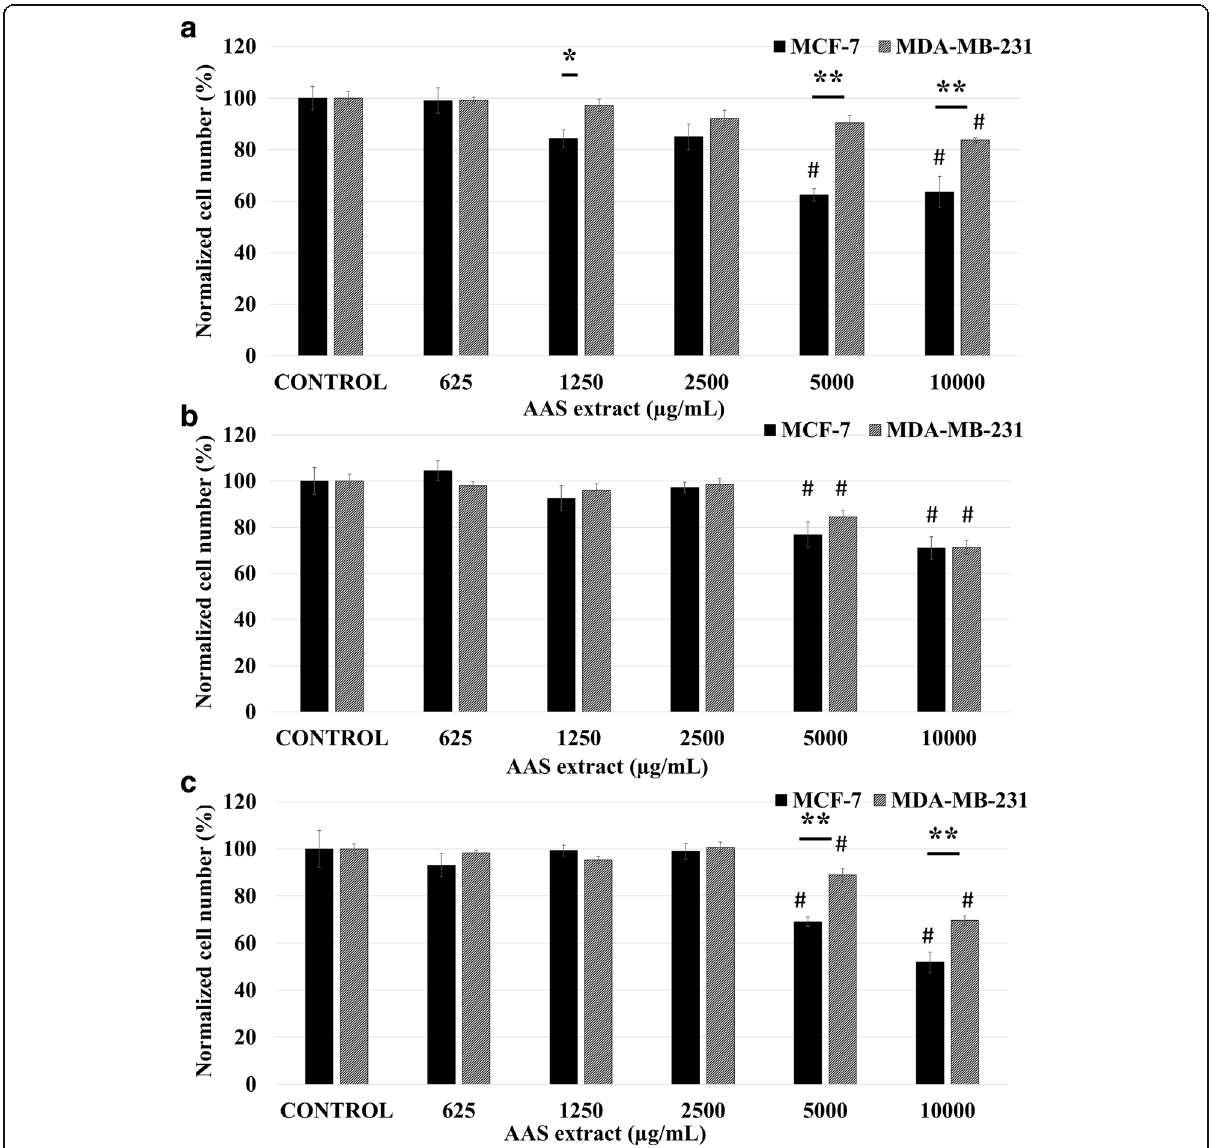
Fig. 2 AAS extract causes significant anti-proliferative effect on MCF-7 and MDA-MB-231 cells. Concentration-effect curves of AAS extract treatment 625 – 10,000 μ g/mL for 24 h ( a ), 48 h ( b ), and 72 h ( c ) in MCF-7 and MDA-MB-231 cells. Normalized cell number was calculated by using measurements from six independent MTT assays. Data is represented as mean±S.E.M. Statistical significance: #, p <0.05 vs control according to ANOVA followed by Newman-Keuls post hoc analysis. *, p <0.05 and **, p <0.01 MCF-7 vs MDA-MB-231 according to Student ’ s t-